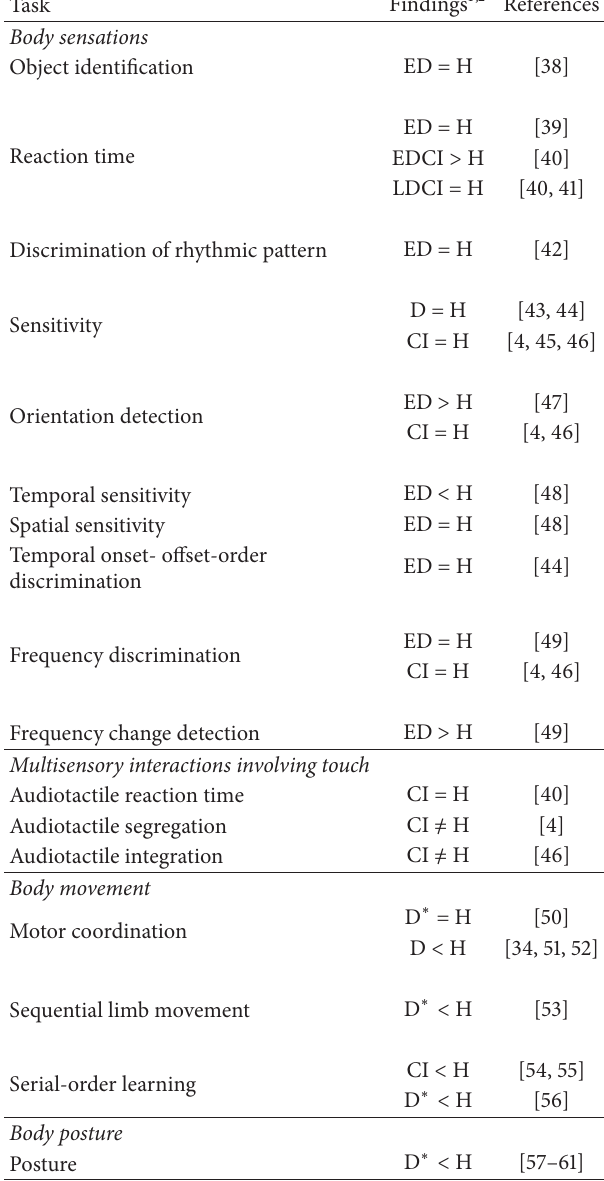
Table 1: Body-related abilities for deaf and hearing